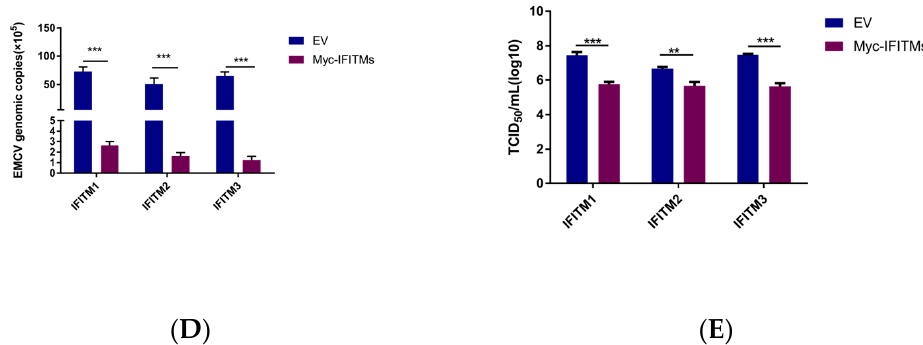
Figure 2. HEK293 cells were transfected with pCMV-Myc-IFITM1 (1 µ g), -IFITM2 (1 µ g), and -IFITM3 (1 µ g) plasmid, respectively. pCMV-Myc empty vector (1 µ g) served as control. Cells were infected 24 h post-transfection with 0.001 MOI EMCV PV21 strain for 24 h. Then, collected virus for viral genomic copies detection or determining infectious progeny viral titers via the TCID 50 assay. ( A – C ) IFITM proteins overexpression was detected via Western blotting in HEK293 cells with a Myc-tagged antibody. β -actin served as a loading control. ( D ) EMCV genomic RNA copies were detected using real-time TaqMan PCR. ( E ) Infectious progeny viral titers were determined via the TCID 50 assay. Data were represented as mean ± SDs of three independent experiments and were measured in technical duplication. Comparisons between groups were performed using the Student’s t -test. *** p < 0.001, ** p < 0.01.